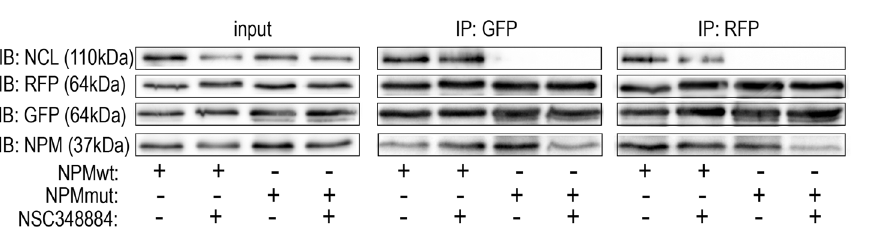
Figure 11. Interaction potential of NPM in NSC348884-treated cells. Immunoprecipitation from 293T cells co-transfected with G_NPMwt + R_NPMwt (NPMwt) or G_NPMmut + R_NPMmut (NPMmut) in control and NSC348884-treated sample (10 µM NSC348884 for 24 h). All exogenous forms as well as the endogenous NPM were detected in all eGFP- and mRFP1-precipitates regardless the NSC348884 addition. Nucleolin (NCL) was detected in NPMwt-precipitates only, independently of the NSC348884